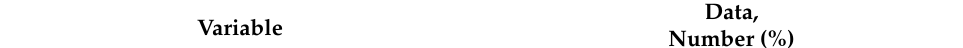
Table 3. Attitudes and practice of pediatricians about antibiotics and antimicrobial resistance. Variable